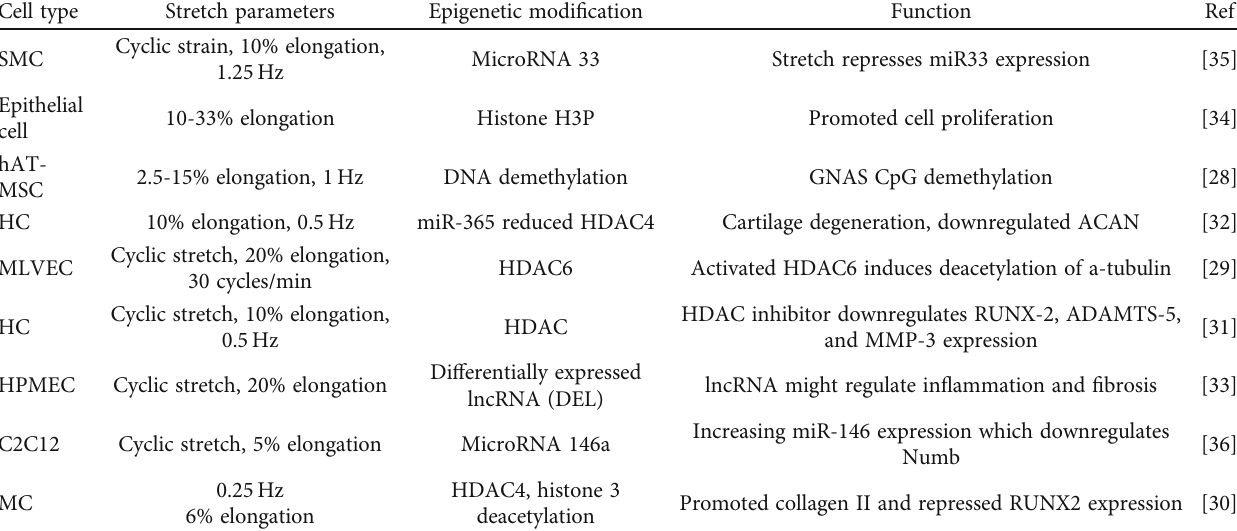
Table 2: Summary or examples of the e ff ects of mechanical stretch on histone modi fi cations.